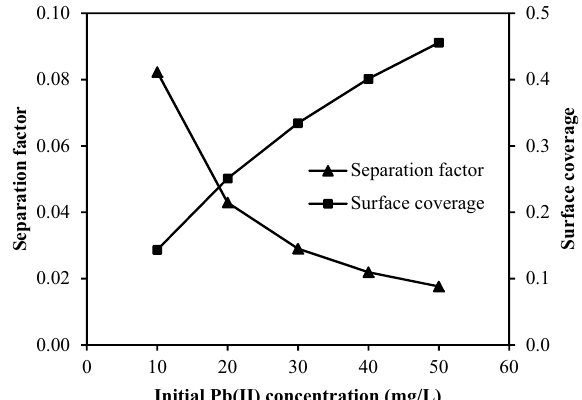
Figure 8. A plot of separation factor and surface coverage against initial concentrations of